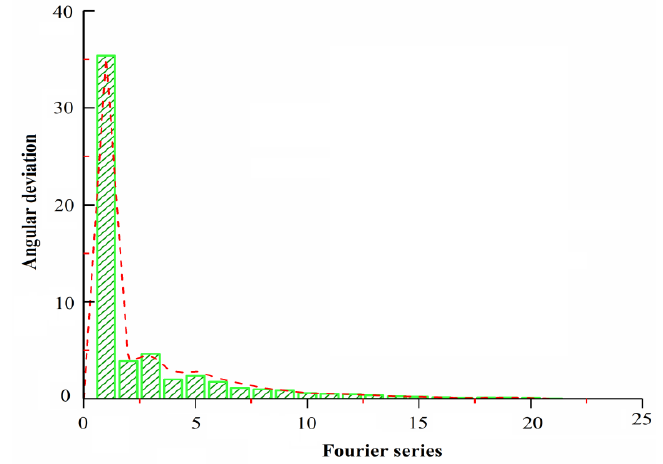
Figure 4. Analysis of high-order harmonic